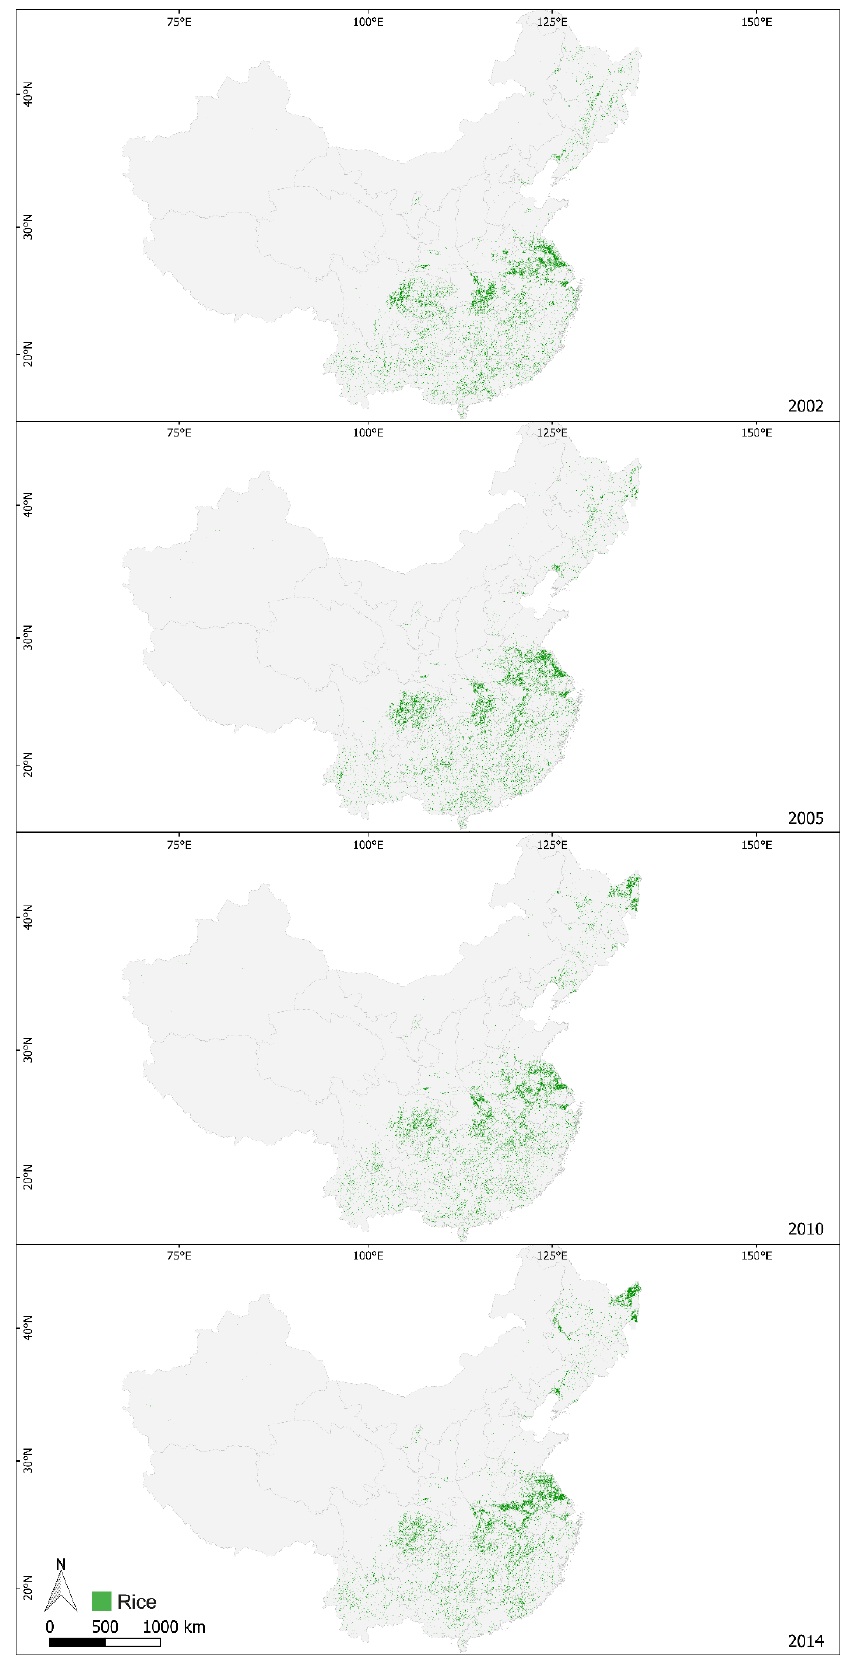
Figure 5. Paddy rice classifications for mainland China.